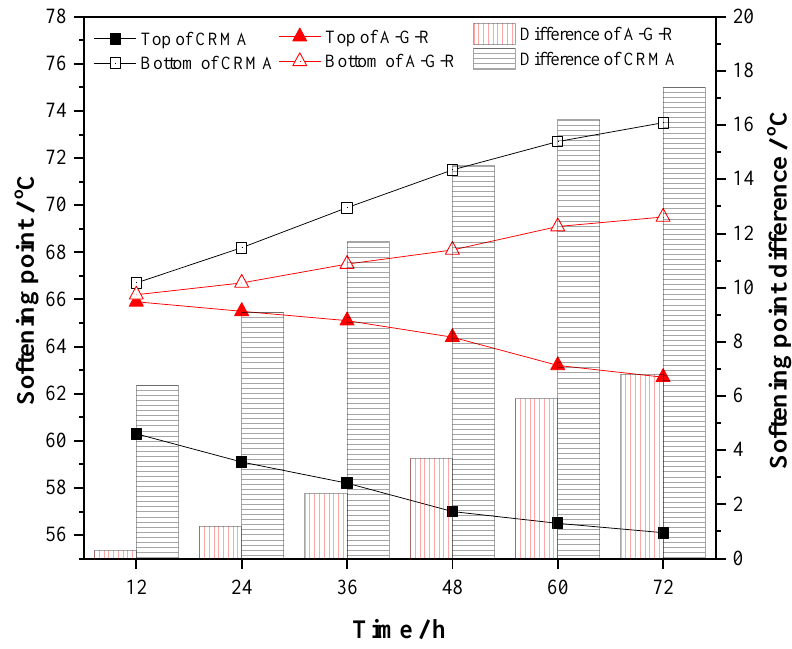
Figure 10. The softening point and softening point difference of CRMA and A–G–R.